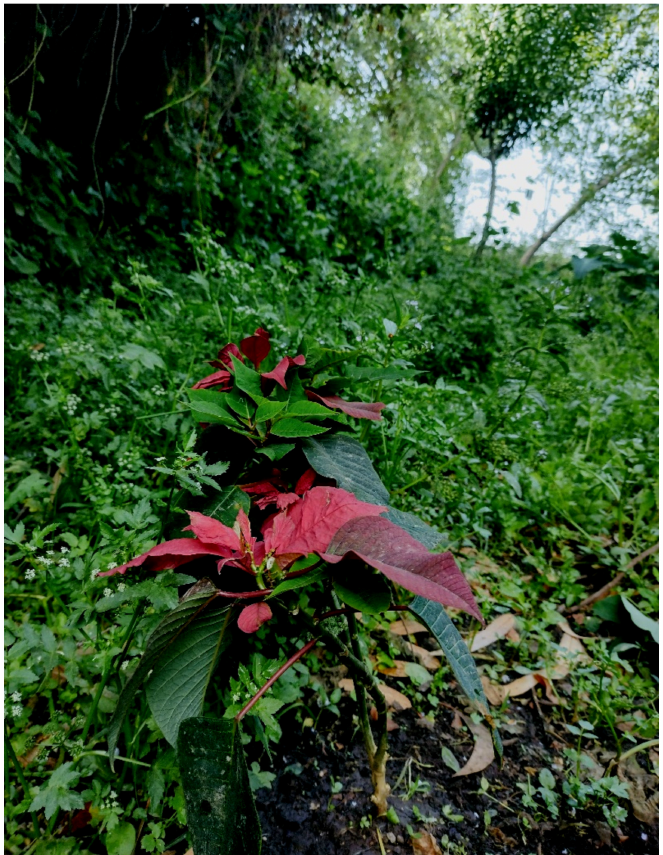
Figure 45. Euphorbia pulcherrima on riverbed of channel Acqua Mariana (Acquedotti